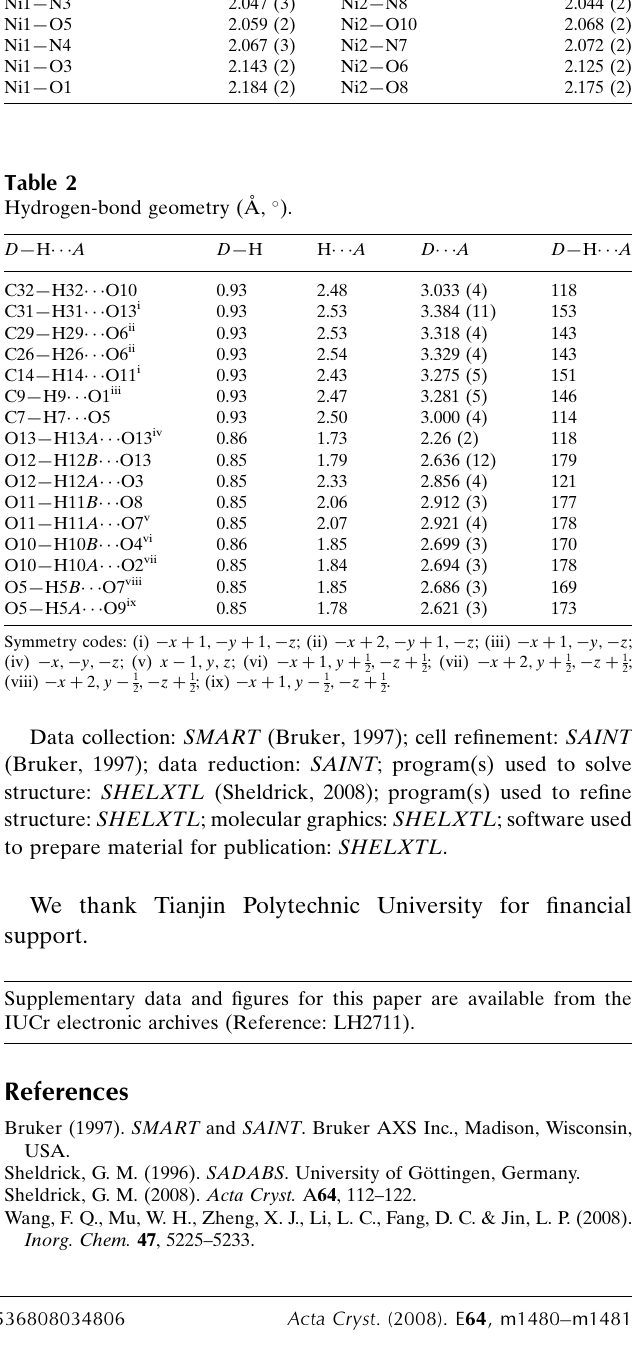
Selected bond lengths (A˚ ).